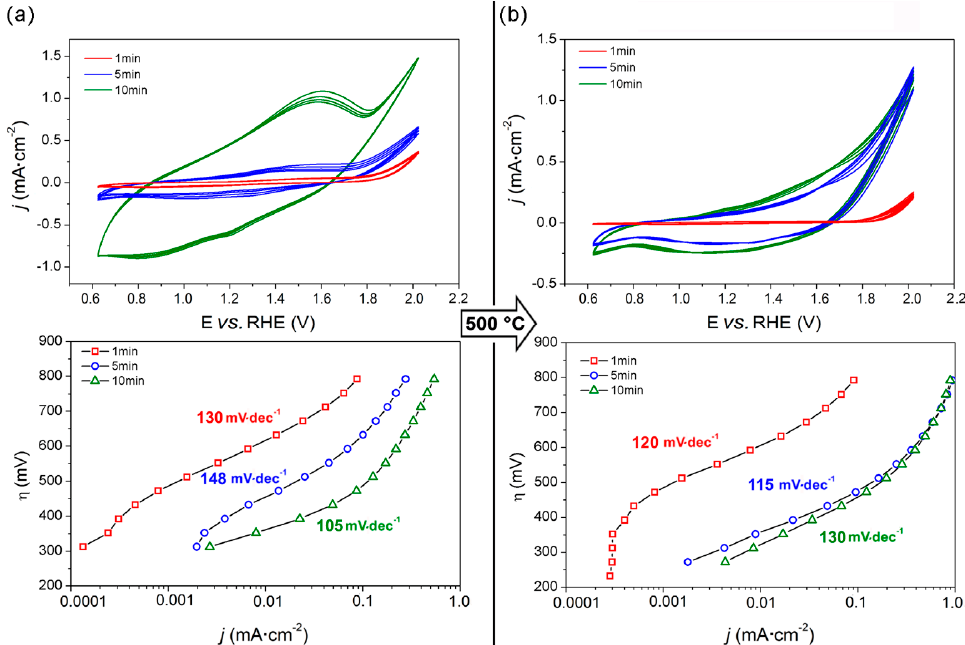
Figure 4. Electrochemical characterization of ED films prepared by electrodeposition at different deposition times: cyclic voltammograms (upper panel) and Tafel plots (lower panel) of the as-deposited ( a ) and calcined ( b ) films in 0.1 M Na-phosphate buffer (pH = 7.0). Potential (E) is referred to the RHE (see Section 2.5).